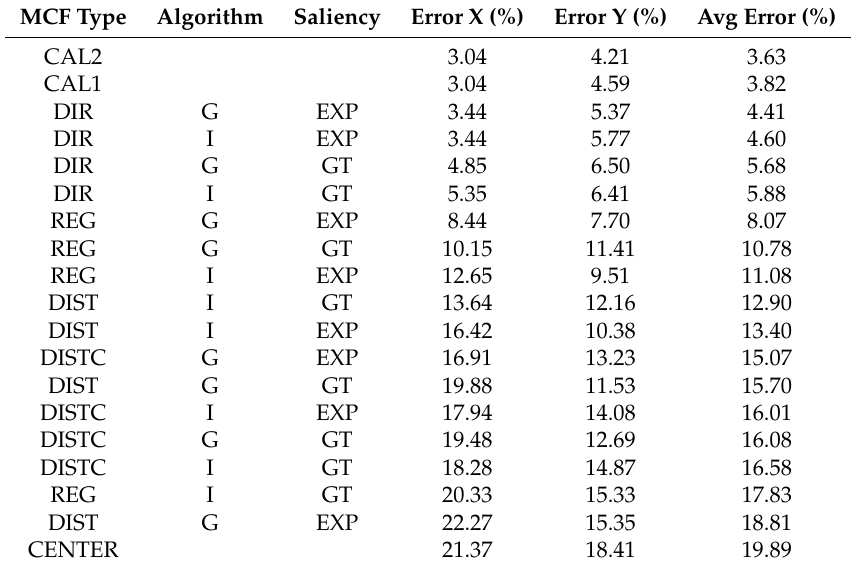
Table 7. Average errors for GT PFTs and various mapping comparison functions (MCF).